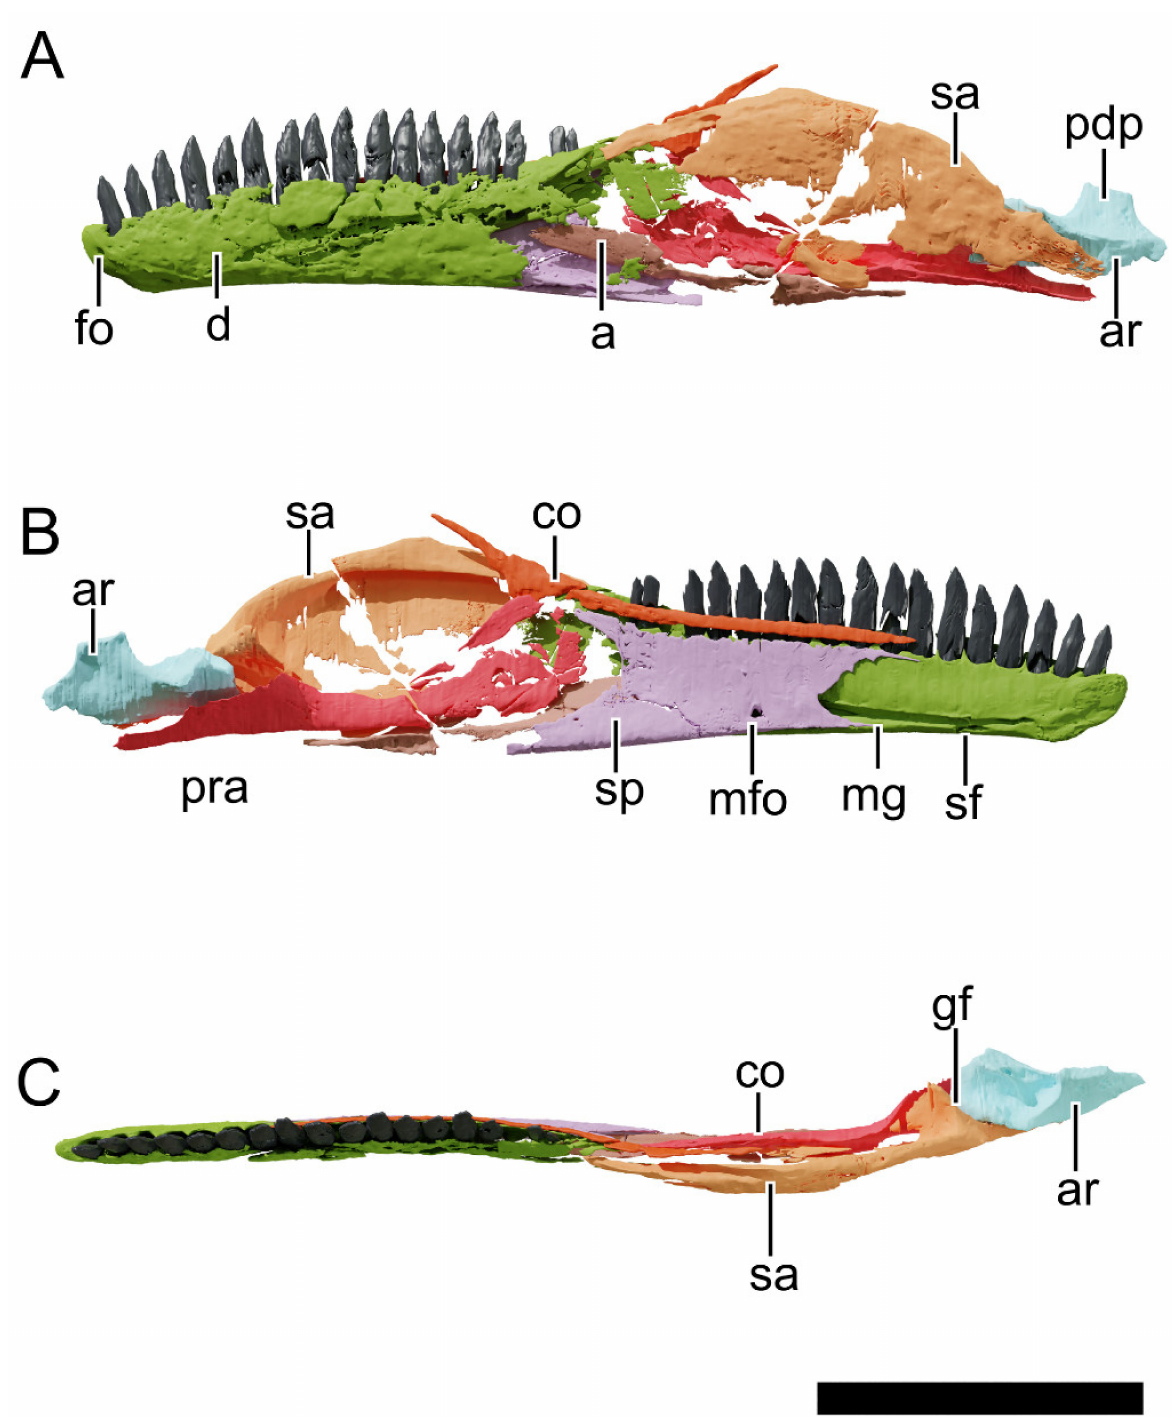
Figure 31. Digital reconstruction of the left mandible of NHMD 164758. ( A ) Lateral view. ( B ) Medial view. ( C ) Dorsal view. Abbreviations: a, angular; ar, articular; co, coronoid; d, dentary; fo, foramen; gf, glenoid fossa; mf, mandibular fenestra; mfo, mylohyoid foramen; mg, Meckelian groove; pdp, posterodorsal process; pra, prearticular; sa, surangular; sf, secondary fossa; sp, splenial; sy, symphysis. Scale bar = 50